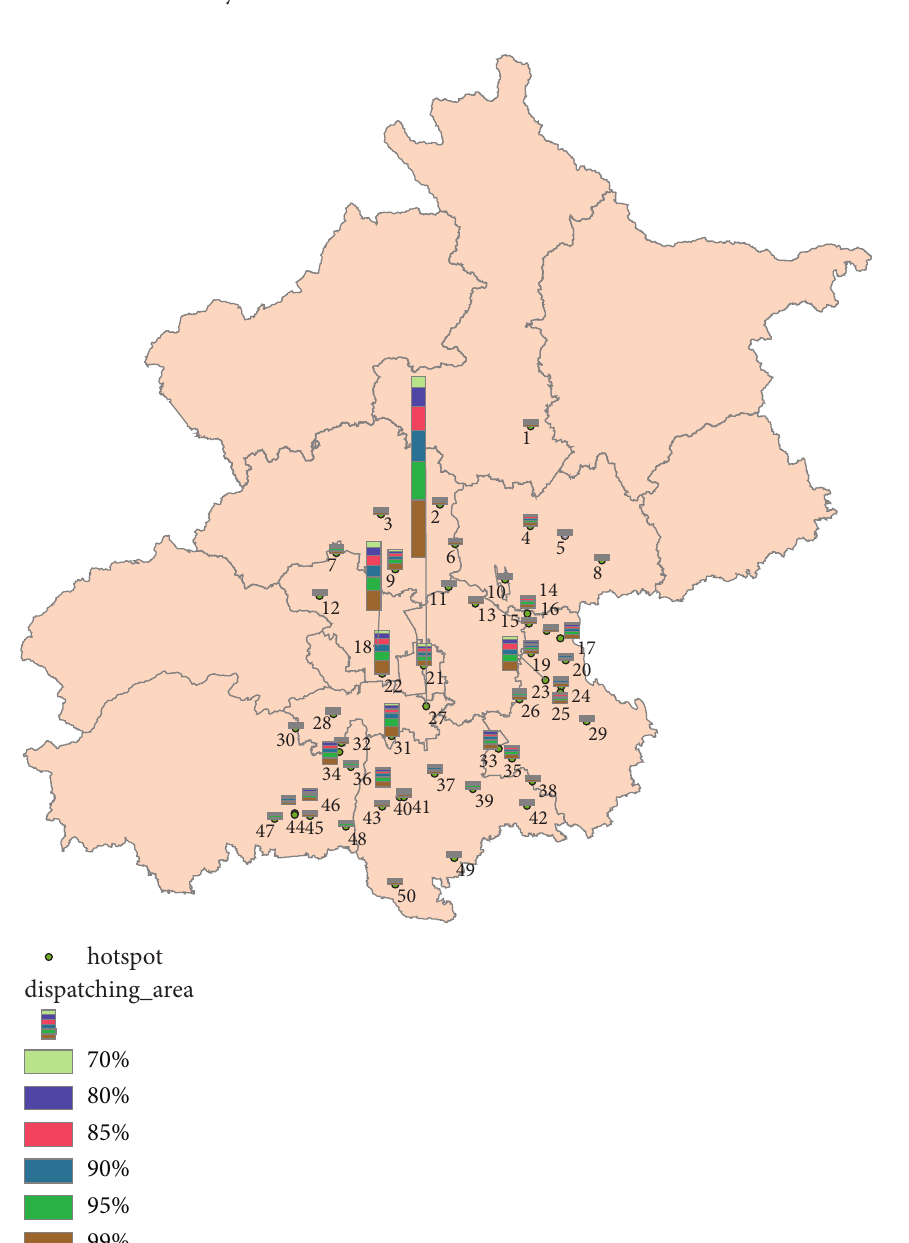
Figure 12: Spatial distribution characteristics of dispatch